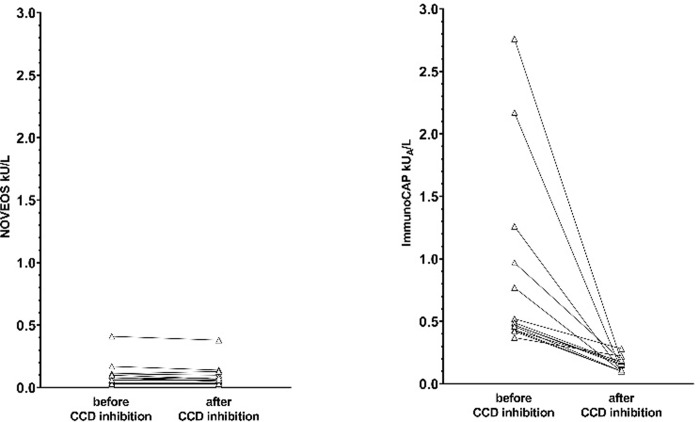
Change in specific IgE results against recombinant components before and after CCD inhibition focusing on the 14 false-positive results observed on ImmunoCAP.(a) NOVEOS Specific IgE results. (b) ImmunoCAP Specific IgE results.